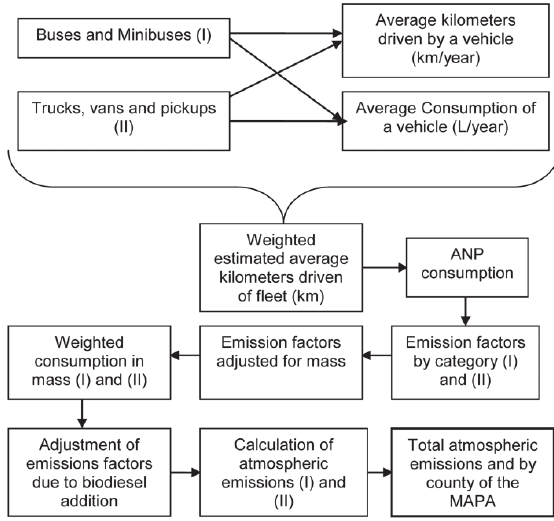
Fig. 2 - Flow chart of the calculation